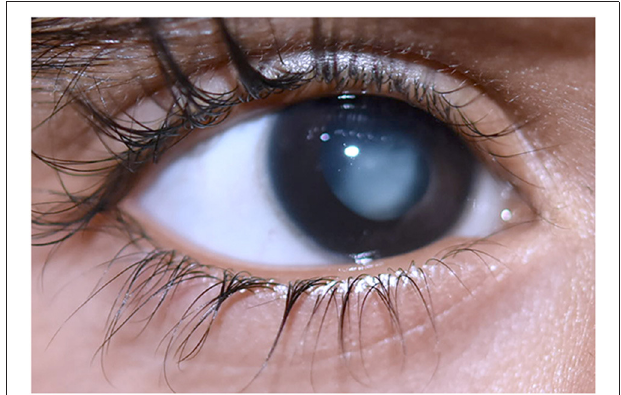
FIGURE 1 | Morphology of persistent hyperplastic primary vitreous in a 1-year-old boy with white vascularized retrolental tissue. Image obtained with prior informed consent from the parents of the patient.